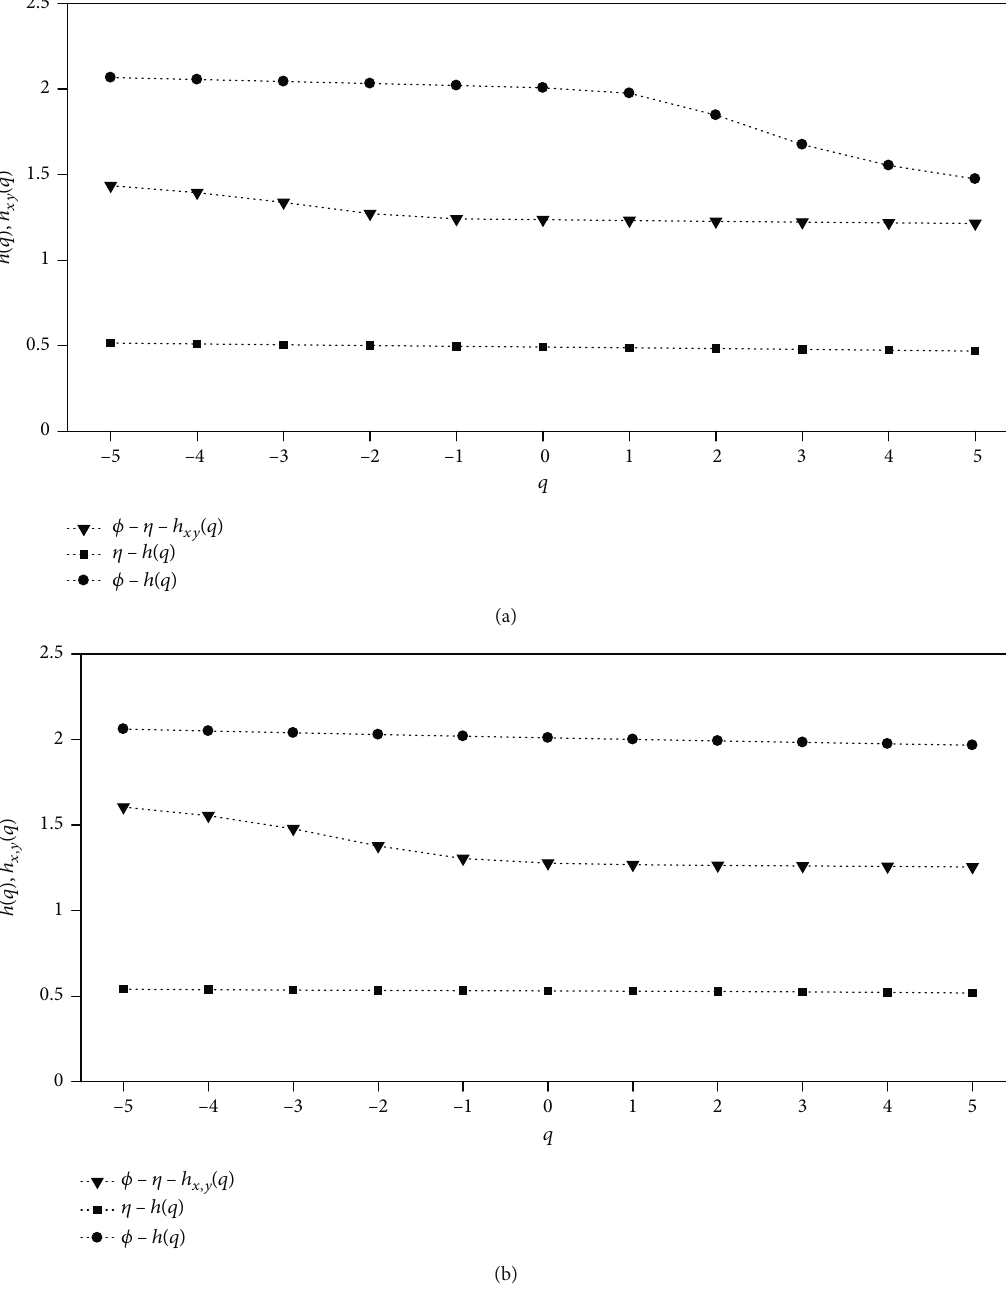
q Þ versus q for q = − 5, − 4, ⋯ , 5 , calculated for a particular range of η values and their corresponding ϕ values Figure 5: Trend of h ð q Þ and h x , y ð for (a) 8 TeV dataset and (b) 7 TeV